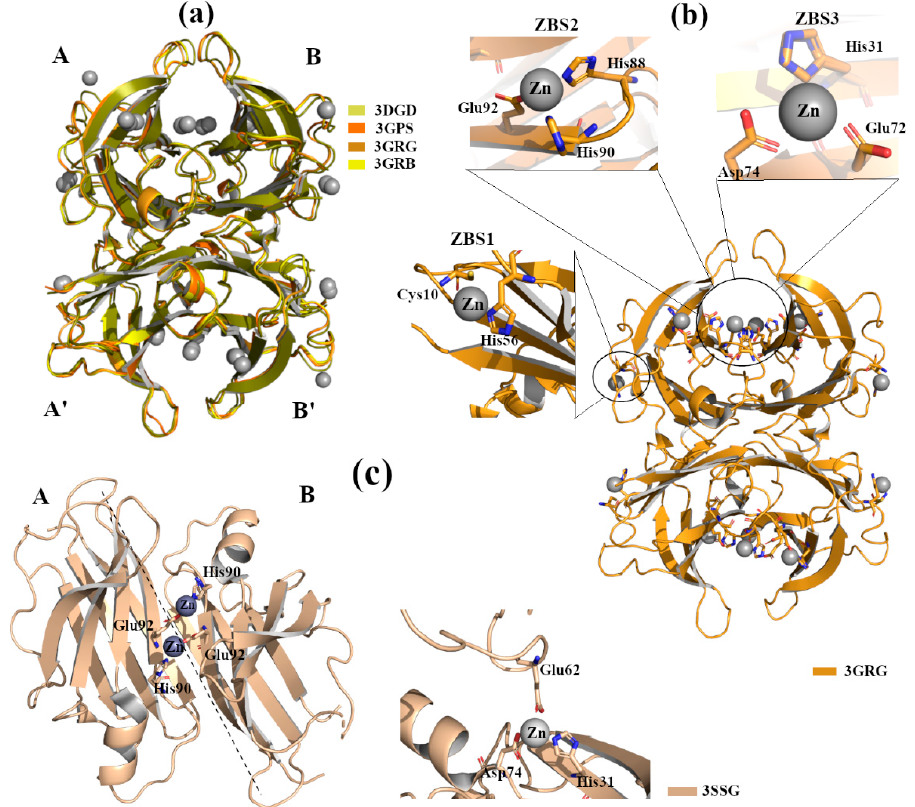
Figure 3. TTR crystal structures in complex with Zn 2+ . The figure was created by author downloading the appropriate PDB codes. ( a ) Superposition of the four Zn 2+ -M-TTR obtained at different pHs (PDB id: 3GRG pH 7.5, 3GRB pH 6.5, 3GPS pH 5.5, 3DGD pH 4.6). Zinc ions are colored in grey. ( b ) Graphical representation of ZBS1-3 in the M-TTR crystal structure (PDB id: 3GRG). ( c ) Graphical representation of ZBS1-2 in the L55P-TTR crystal structure (PDB id: